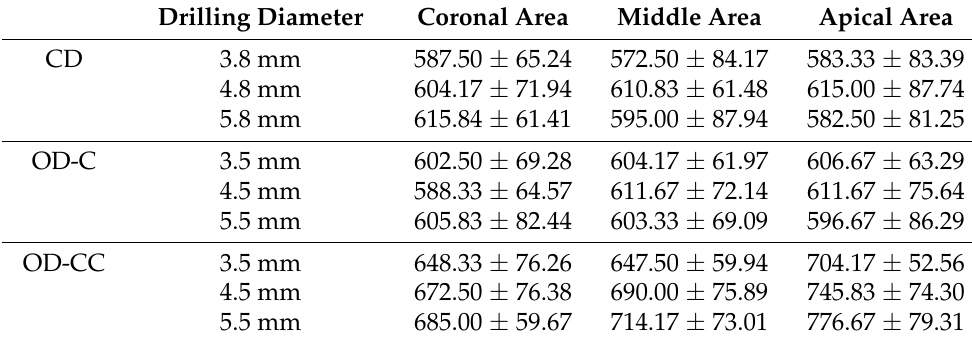
Table 3. Hounsfield unit gaps in